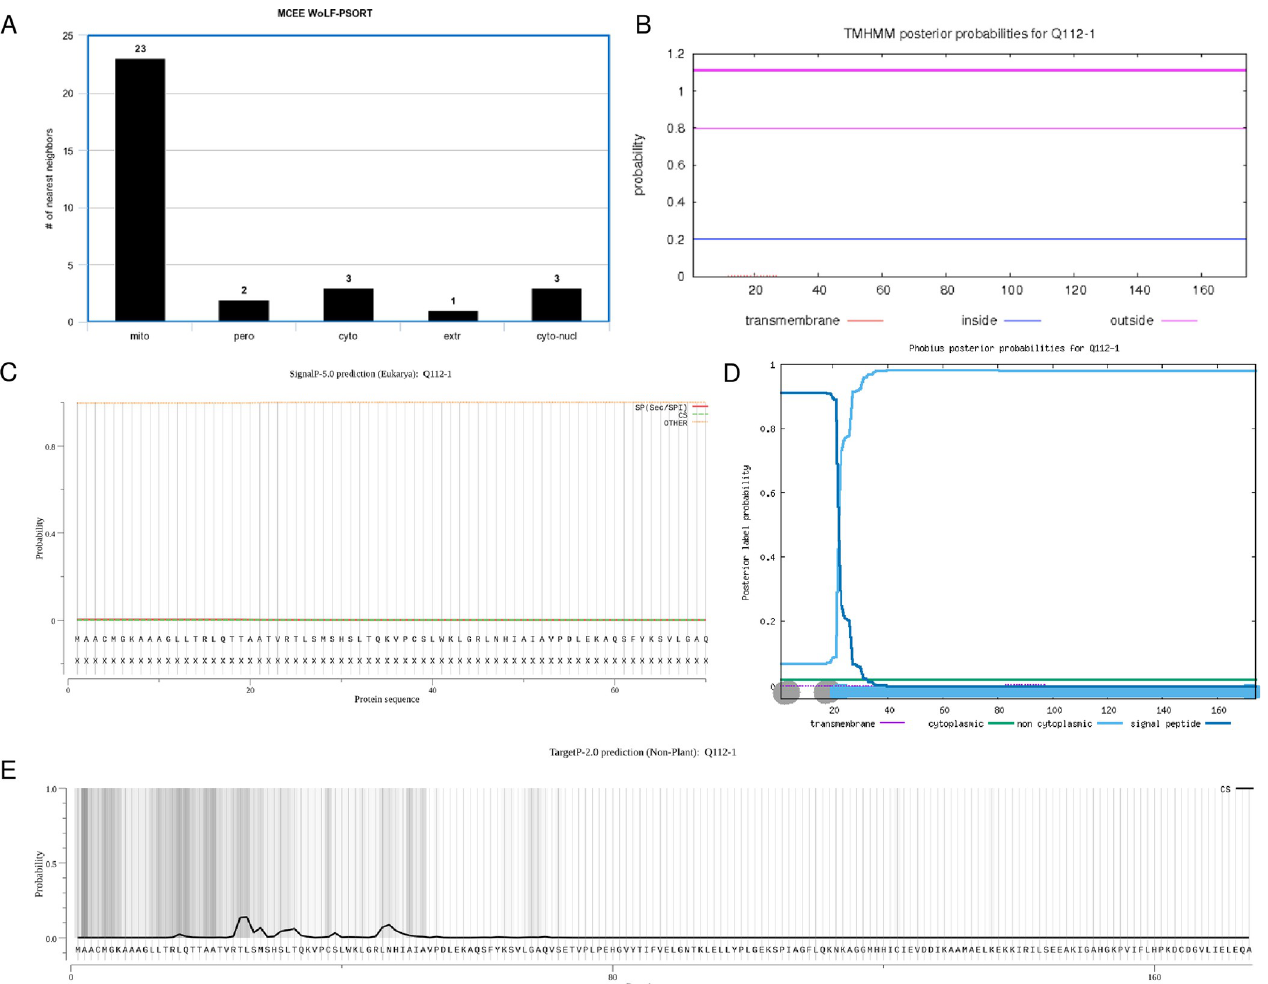
Fig 7. Subcellular localization of the MCEE enzyme. (A) Bar chart showing WoLF PSORT prediction of the protein’s localization sites based on 32 nearest neighbors. Mito, mitochondria; pero = peroxisome; cyto = cytoplasm; extr = extracellular; cyto-nucl, cytoplasm and nucleus. (B) TMHMM prediction of TMHs. X-axis represents the amino acid number, and y-axis represents the probability that the amino acid is located within, outside, or inside the membrane. Probabilities > 0.75 are significant. (C) SignalP analysis of signal sequences existing in the amino acid sequence of the polypeptide. (D) Phobius predictions of TMHs and signal peptides. X-axis represents the amino acid number, and y-axis represents the probability that the amino acid is transmembrane, cytoplasmic, non-cytoplasmic, and/or a signal peptide. Probabilities > 0.75 are significant. (E) TargetP-2.0 prediction of N-terminal pre-sequences, signal peptides, and transit